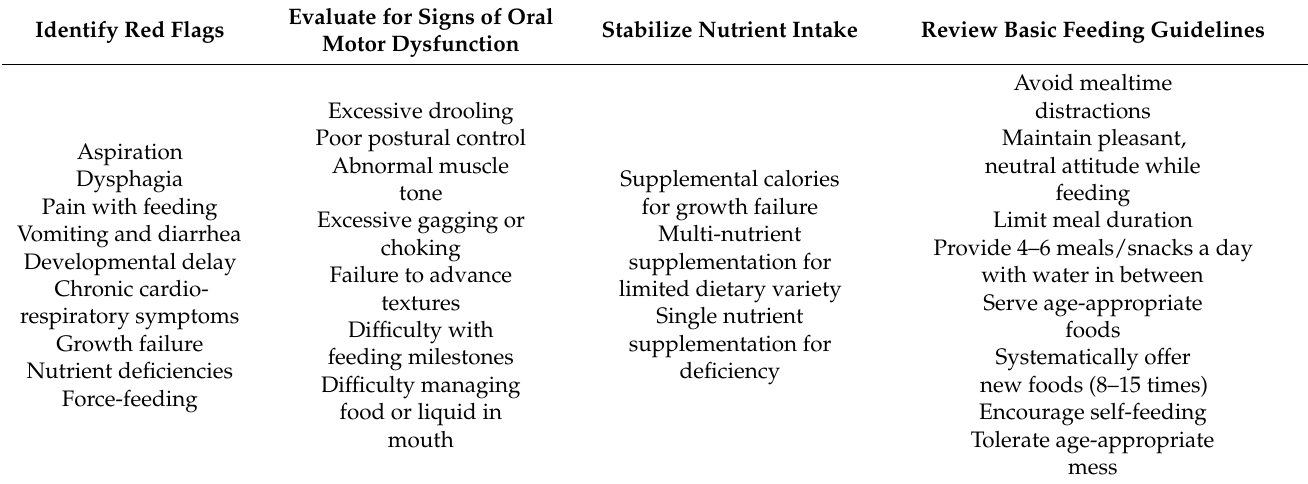
Table 3. Initial Management of Pediatric Feeding